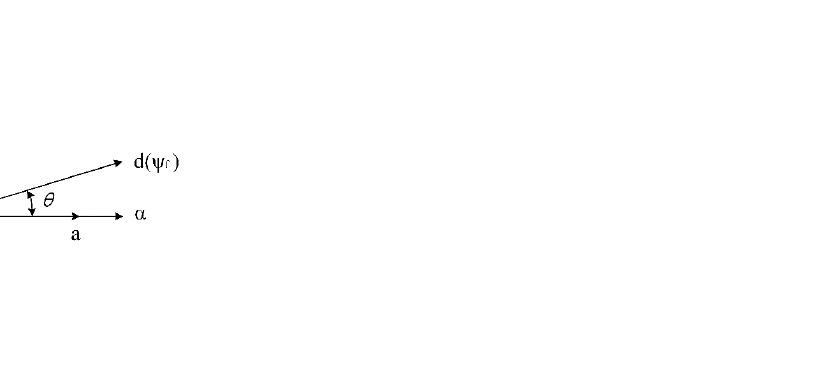
Figure 2. Coordinate system of the PMLSM model: θ is the angle between the A-phase winding axis and the permanent magnet axis, ψ f is the permanent magnet flux linkage.